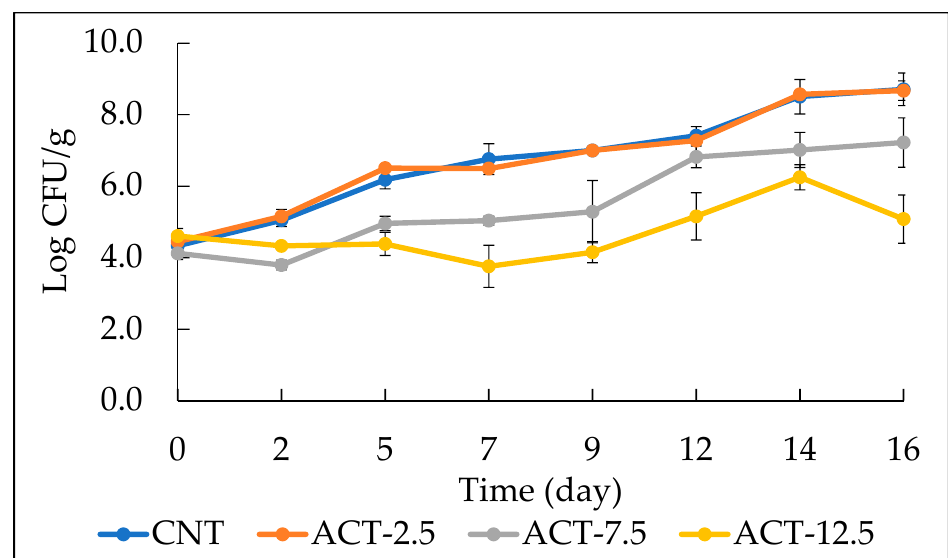
Figure 2. The evolution of total psycrhrotrophic bacteria in fish burgers during 16 days of storage at 4 °C. Data indicate means ± SD. CNT: fish burger without prickly pear powder; ACT-2.5: fish burger enriched with 2.5 g of prickly pear powder; ACT-7.5: fish burger enriched with 7.5 g of prickly pear powder; ACT-12.5: fish burgers enriched with 12.5 g of prickly pear powder.